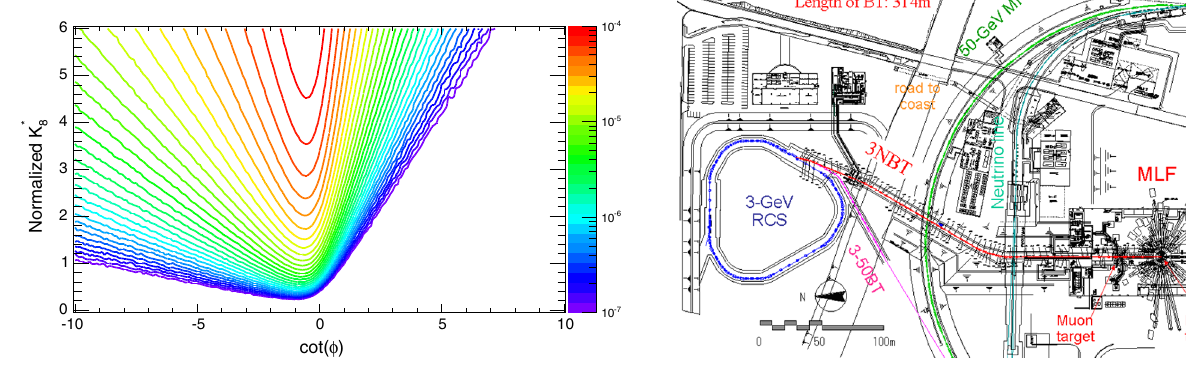
FIG. 8. Plan of rapid cycling synchrotron (RCS) at Materials of linear t and Life Science Experimental Facility (MLF) in J-PARC.